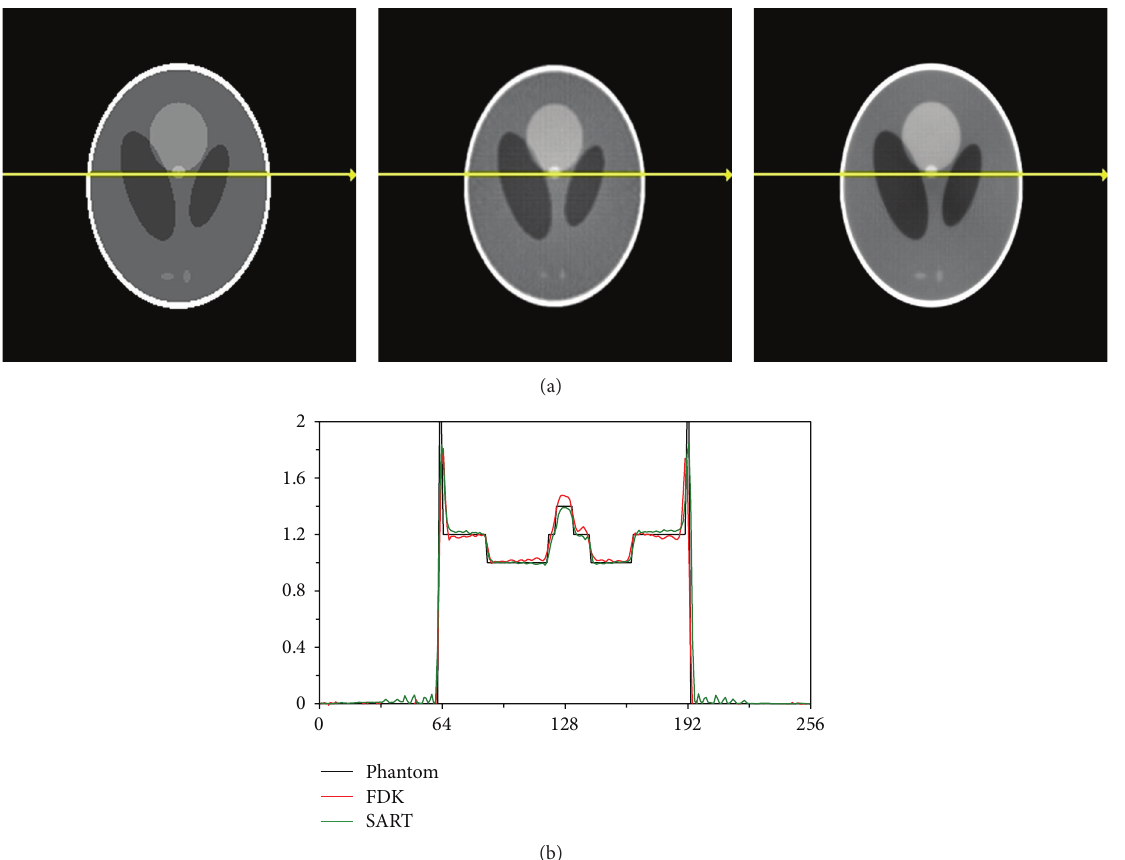
Figure 11: Reconstructions (a) of the (left) Shepp-Logan phantom using the (center) FDK filtered backprojection algorithm and the (right) SART algorithm with (b) a line profile taken through the